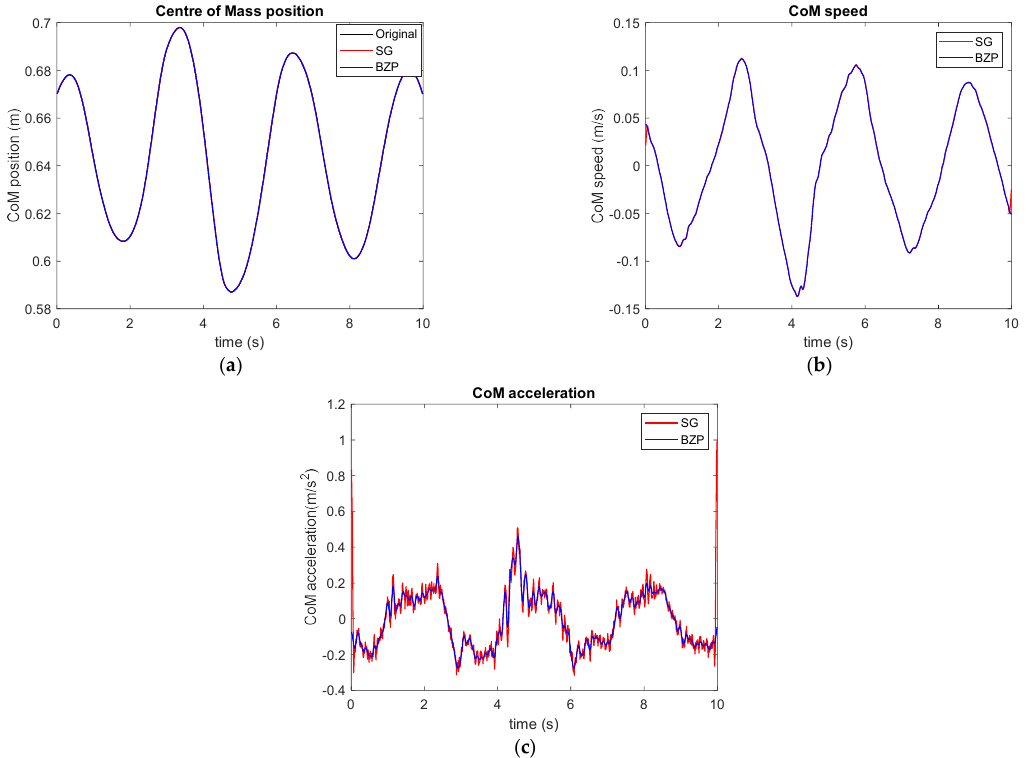
Figure 11. CoM horizontal position ( a ), speed ( b ) and acceleration ( c ) during voluntary oscillation around a stable and constant